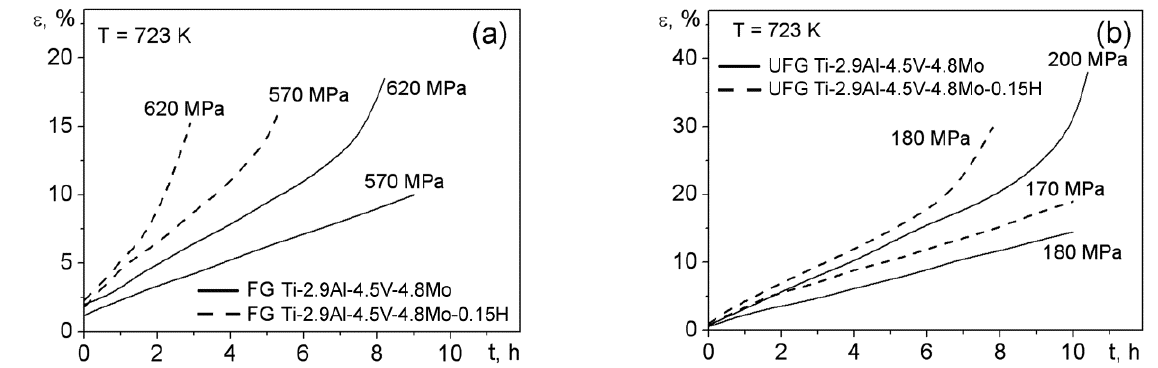
Figure 6. Creep curves: ( a ) FG Ti-2.9Al-4.5V-4.8Mo and Ti-2.9Al-4.5V-4.8Mo-0.15H alloys and ( b ) UFG Ti-2.9Al-4.5V-4.8Mo and Ti-2.9Al-4.5V-4.8Mo-0.15H alloys obtained at 723 K. . ε = . ε f ( lg σ ) (where lg The dependences of lg is the logarithm of steady-state